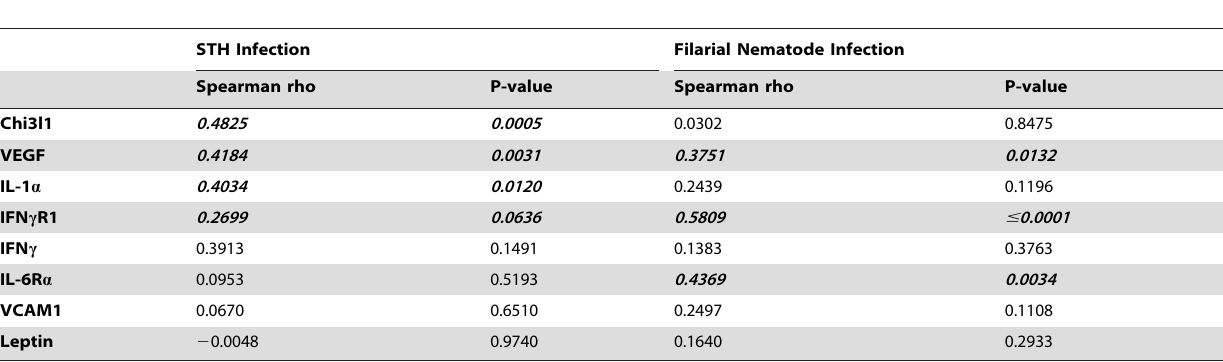
Table 1. Many inflammatory factors are positively correlated with resistin in humans infected with soil-transmitted helminths or filarial